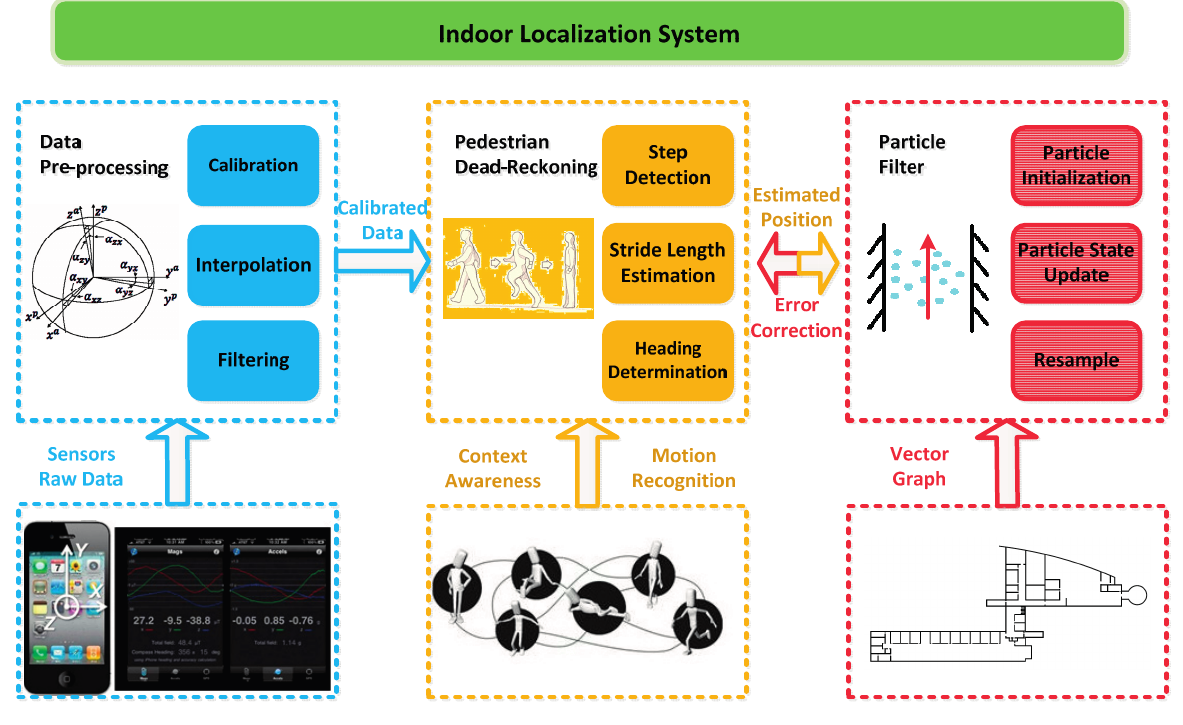
Figure 1. Overall system